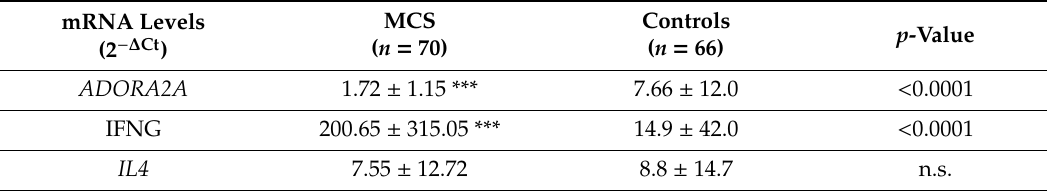
Table 2. mRNA expression levels of genes coding for ADORA2A and inflammatory cytokines in PBMC of MCS patients and healthy